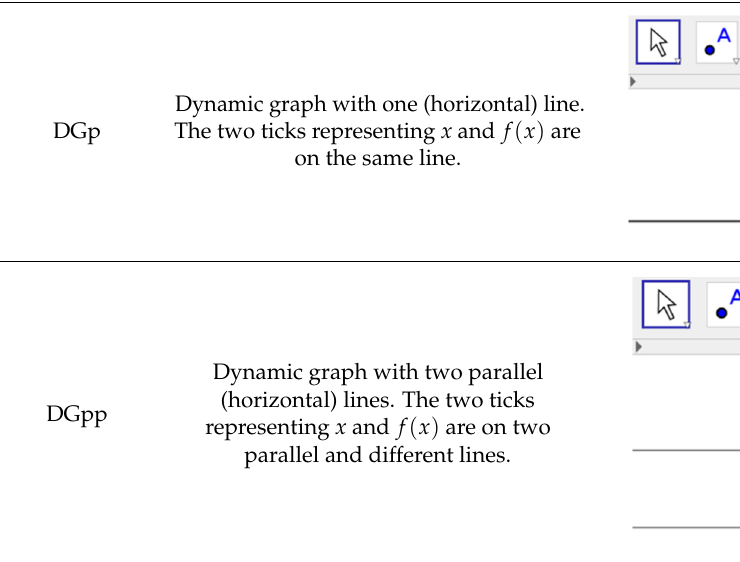
Dynamic graph with one (horizontal) line. DGp The two ticks representing x and f ( x ) are on the same line.